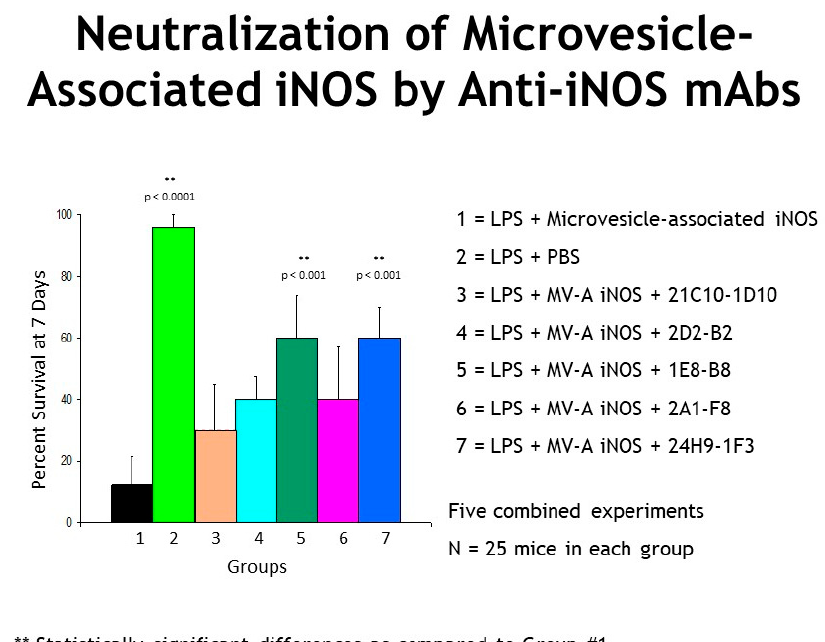
Figure 1. These are the combined data from five different experiments in which we tested all our murine anti-iNOS mAbs. Mice were dosed with LPS at 2 mg/kg at time zero and that was followed with a dose of MV-A iNOS at 4 h. At this dose of MV-A iNOS, 88% (22 of 25 died) of the challenged animals died of sepsis. As Lane #2 shows, if saline is injected at 4 h instead of MV-A iNOS, then more than 95% (24 of 25 lived) of the animals lived because a very low dose of LPS was used to prime the animals. Many of the murine anti-iNOS mAbs in our panel [1] did not rescue mice from death by sepsis since they did not neutralize the lethal effects of MV-A iNOS in vivo even though they all bound to iNOS. However, intervention with the anti-iNOS mAbs illustrated in Lanes # 3–7 did have a beneficial effect since they rescued some of the challenged mice from death by sepsis by stopping the sepsis cascade in these animals. The anti-iNOS mAbs depicted in Lanes # 3–7 were selected for continued investigation as potential candidate therapeutics to treat the sepsis pathology. The mouse monoclonal antibody secreting hybridoma cell lines were used to construct recombinant munotherapeutic candidate to treat sepsis.